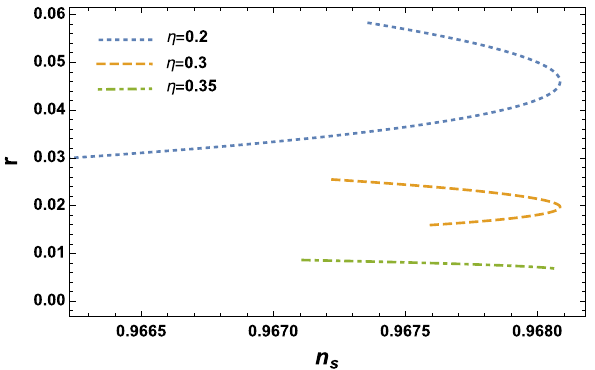
Fig. 10 n s vs r for φ 0 intheinterval3 × 10 − 4 M p ≤ φ 0 ≤ 3 × 10 − 3 M p for N = 60, β = 10 9 and η = 0 . 2 , 0 . 3 , 0 . 35. All curves run though values favored by latest